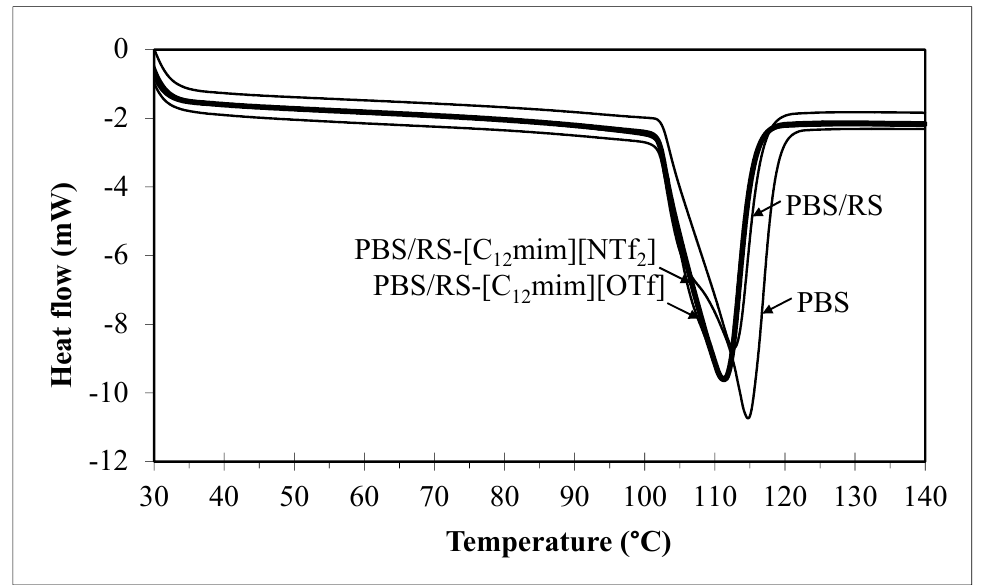
Table 4. FTIR bands of the PBS, RS and PBS/RS blends without and with containing ILbS.